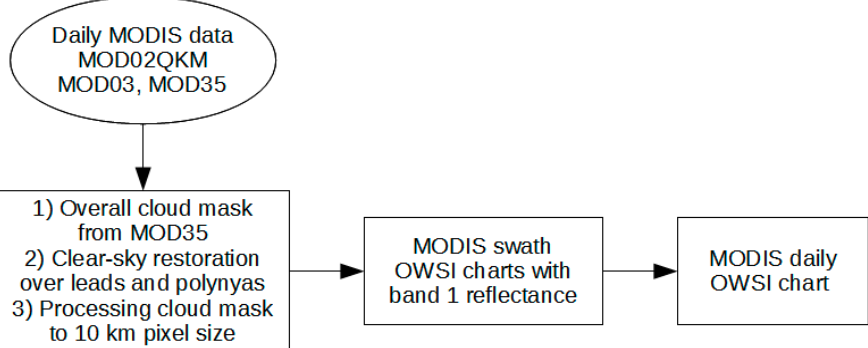
Figure 11. A general flowchart for the MODIS daily open water–sea ice classification chart processing.